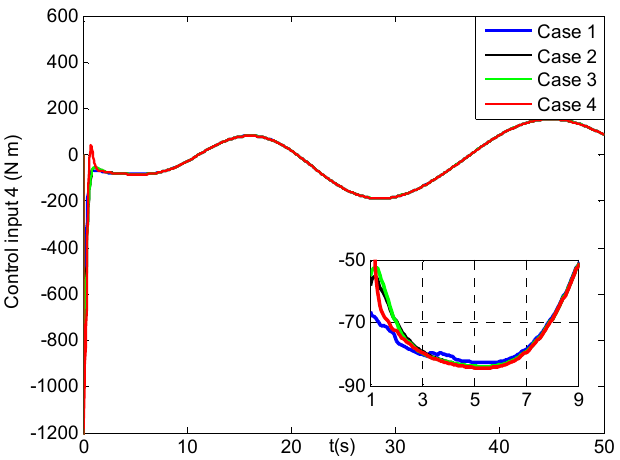
Figure 29. Yaw angle moments for the fourth control input of the vehicle (four cases). Table 6. Average force and moment values of the UVMS under four cases from 10 s to 50 s.